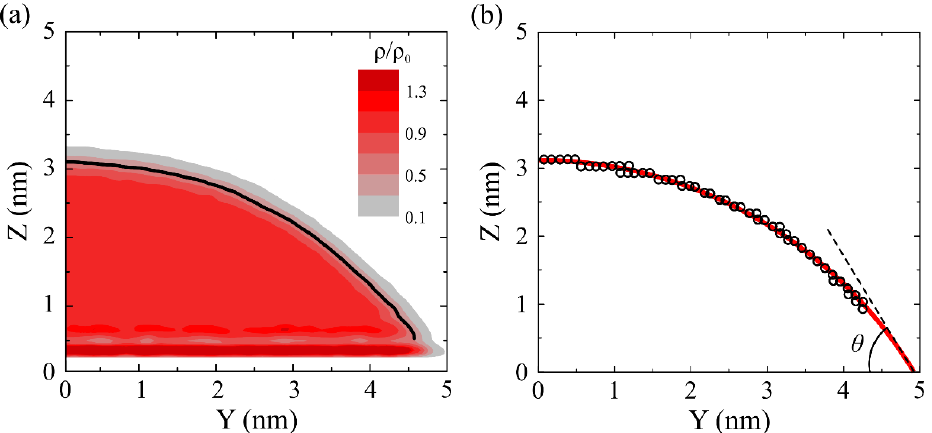
Figure 2. ( a ) Density distribution of water droplet in units of its bulk value. The liquid–vapor interface (the black line) is defined as ρ 0 /2. ( b ) A circular best fit (the red line) through these points with a density level at 0.5 g/cm 3 .